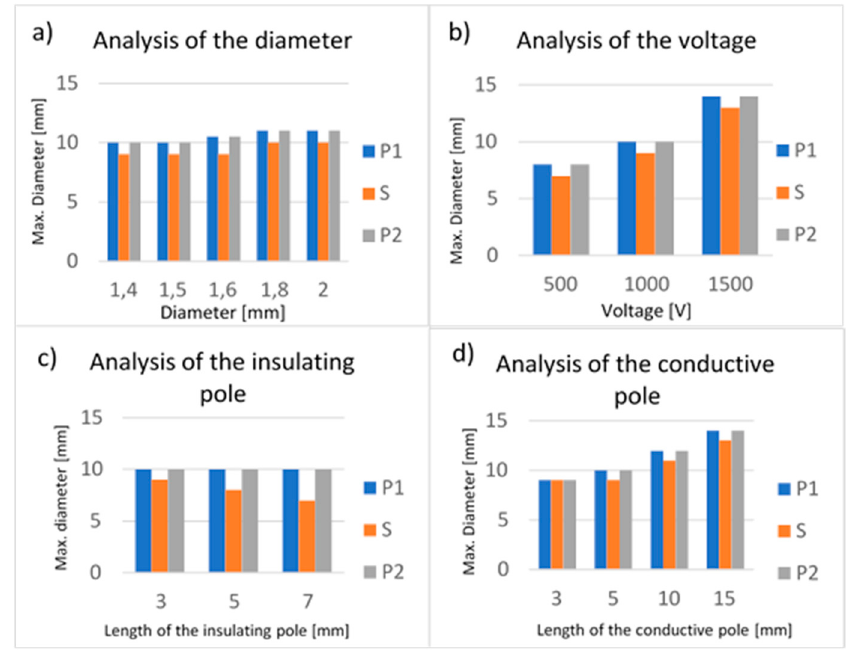
Figure 2. Histograms of tests on electrodes with symmetric geometry (Test 1–4) of Figure 1. In ( a ), ( b ), ( c ) and ( d ) are reported the values of the maximum diameters measured at the distal pole (P1), insulated spacer (S) and proximal pole (P2).